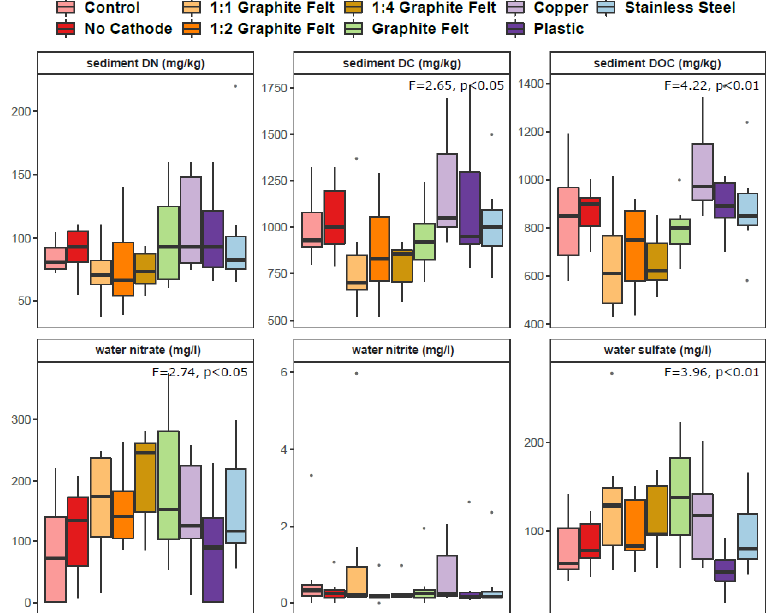
Figure 2. Box plots of sediment and water parameters in nine studied treatments (each n = 6). Statistically significant differences between groups considering different genes are shown with F and p values determined by multivariate analysis. The central line is the median, the edges of the box are the 25th and 75th percentiles, the whiskers represent the 95% confidence interval, and grey dots indicate outliers. Abbreviations: DN – dissolved nitrogen, DC – dissolved carbon, DOC – dissolved organic carbon.